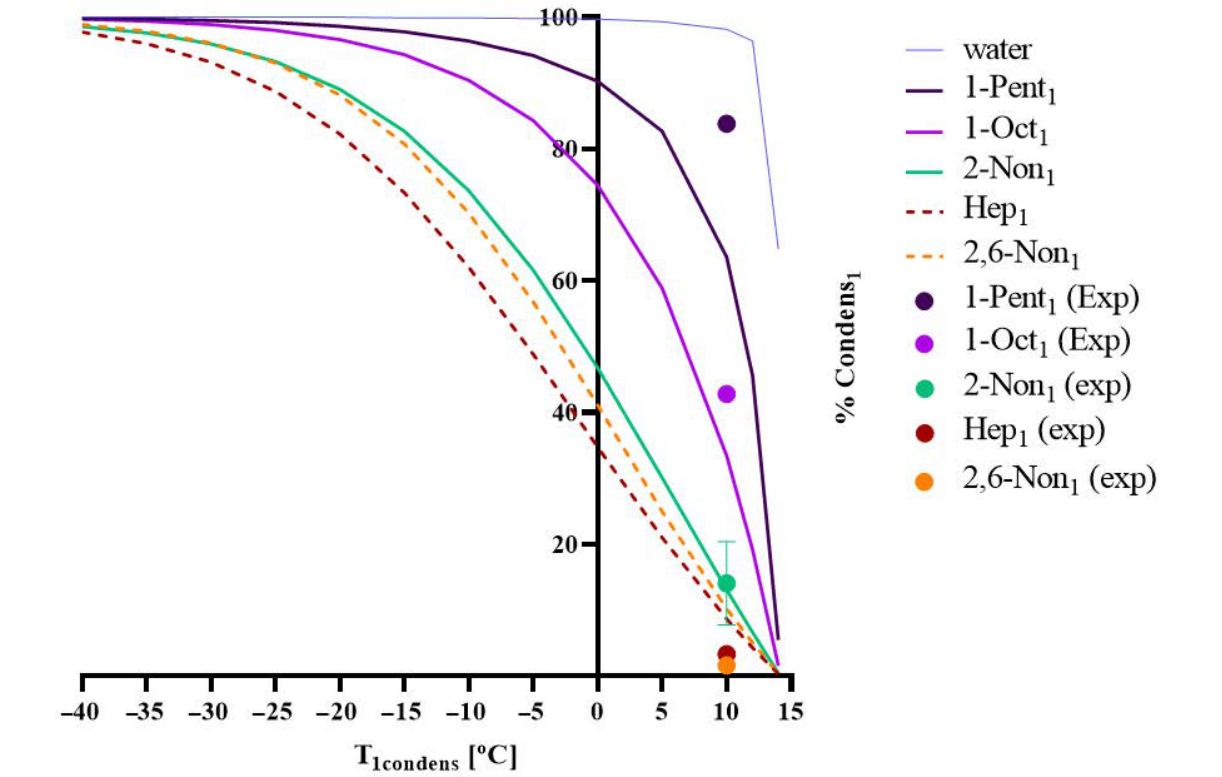
Figure 1. A model simulation was obtained for the sardine cooking wastewaters with experimental validation for five different aroma presents. Percentage of condensation of each compound (water, 1- penten-3-ol, 1-octen-3-ol, heptanal, 2,6-nonadienal, and 2-nonanone) in the 1st condenser ( %Condens i 1 ) as a function of the temperature of the same condenser ( T 1 ,condens ). Operating conditions: Pervap 4060 membrane; T feed = 60 ◦ C; p perm = 1500 Pa; lines refer to simulated values and dots to experimental data, which were analysed in